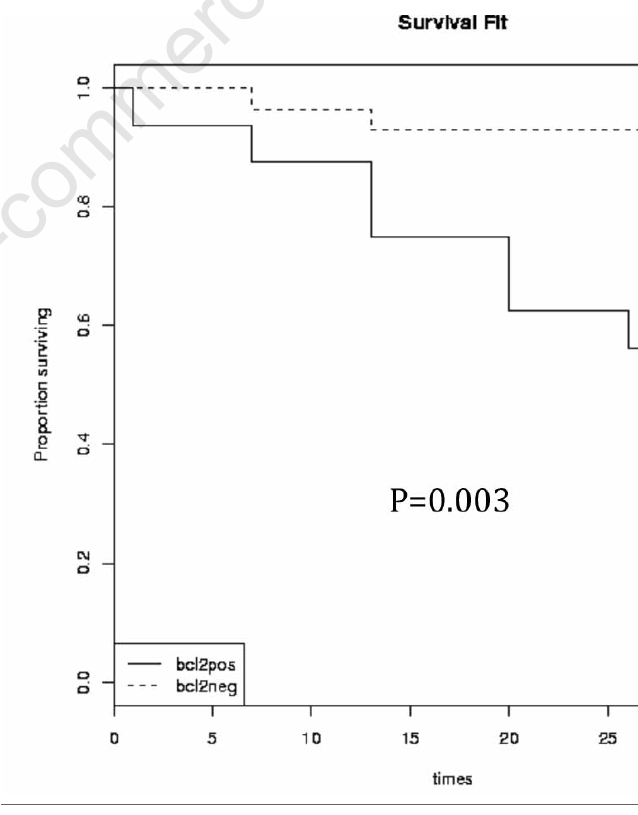
Figure 4. Kaplan-Meier overall survival and disease-free survival times in relation to Bcl-2 protein